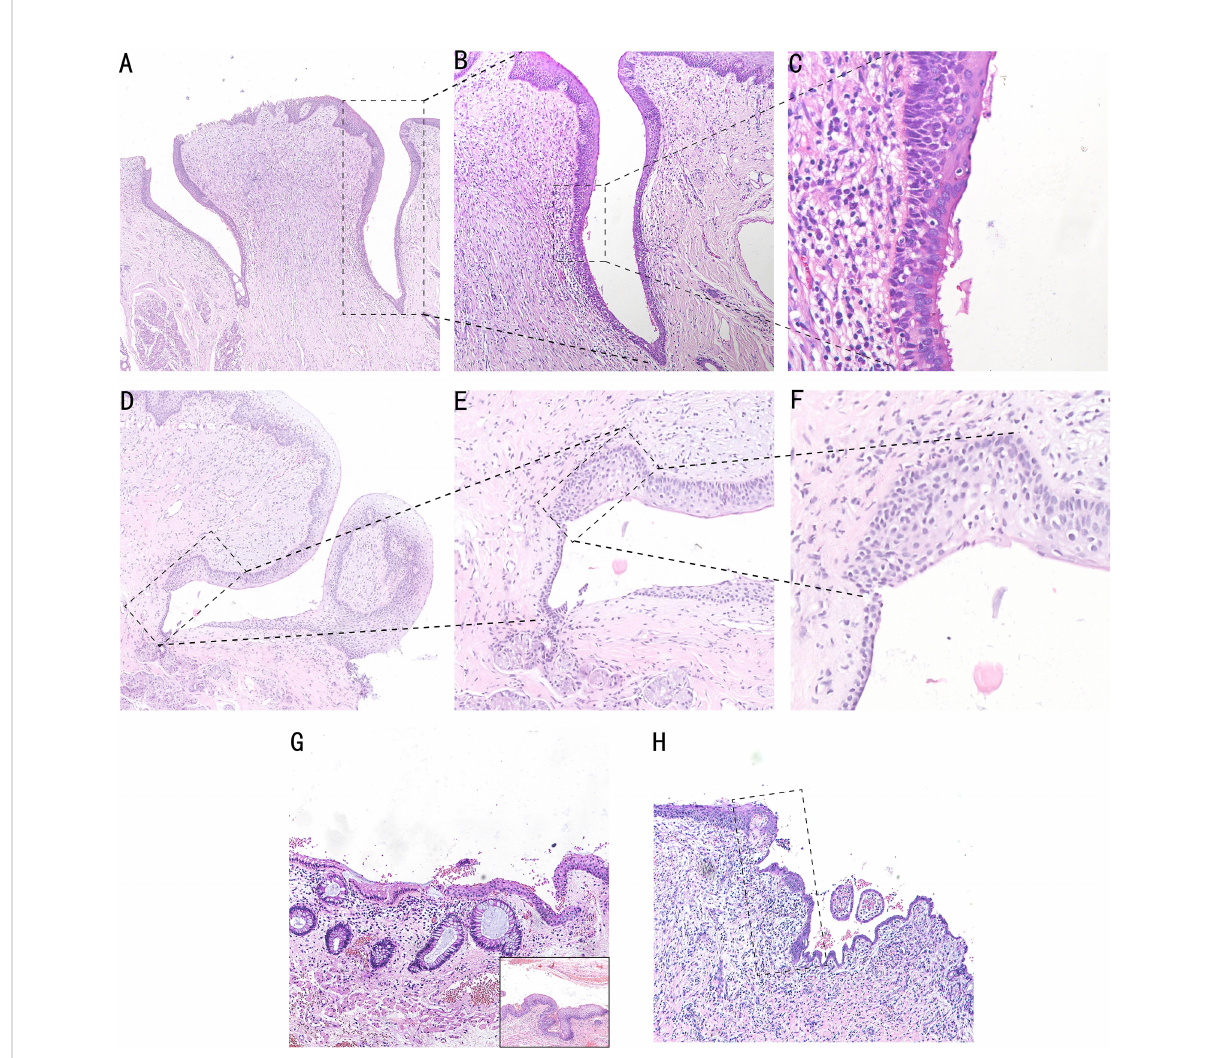
FIGURE 3 HE staining in the human cervix, anus, and Von Ebner ’ s gland. The SCJ in the opening of Von Ebner ’ s gland. Pseudostrati fi ed ciliated columnar epithelium of the columnar area and strati fi ed squamous epithelium of the squamous area can be seen ( A , ×5; B , ×10; C m ×20). (D – F) HE staining of squamous metaplasia SCJ of Von Ebner ’ s gland, and transitional area hyperplasia can be seen in the dotted line area, which is shown as a multilayered epithelium ( D , ×4; E , ×10; F , ×20). (G) HE staining of anal SCJ, and the multilayered epithelial structure of the transitional zone can be seen. In the bottom right section of the image, the junction of the transitional zone with the squamous epithelial is shown ( G , ×4). (H) HE staining of cervical SCJ, and the dotted line area is the transitional zone with a monolayer epithelial structure ( H ,